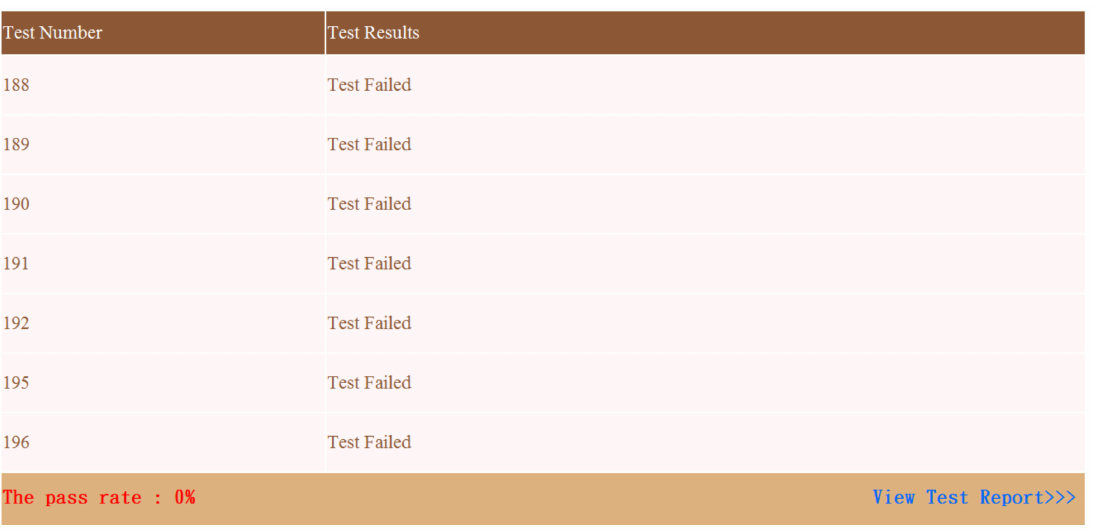
Figure 24. Test result